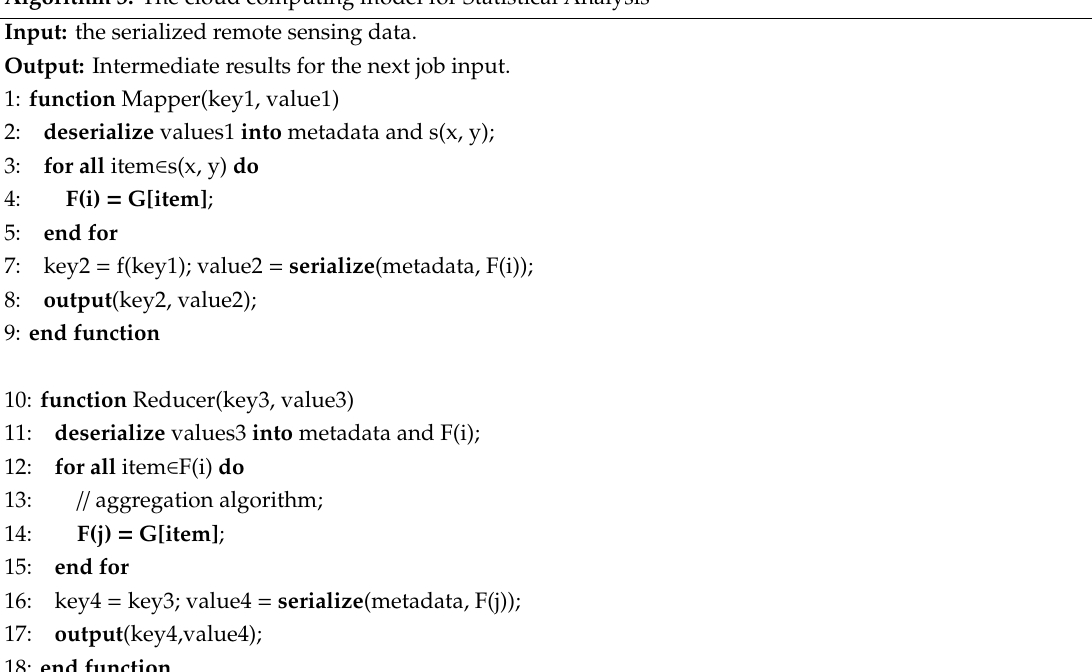
Algorithm 3: The cloud computing model for Statistical